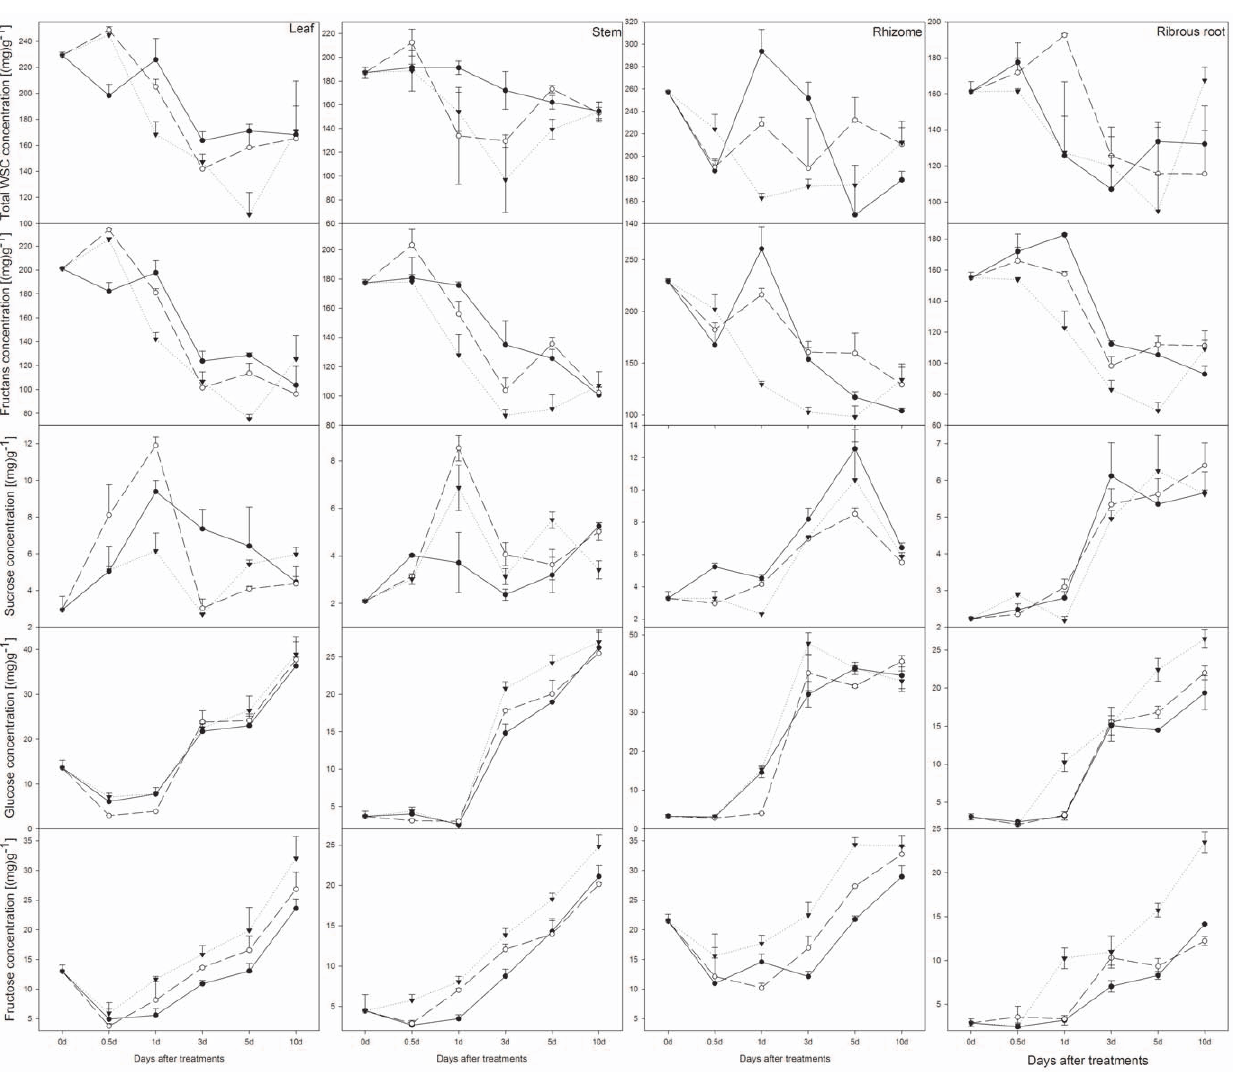
Figure 2. Response of carbohydrate concentrations. The differences between clipping without (real line) and with saliva (broken line) in carbohydrate concentrations, fructans (a 1 –a 4 ), sucrose (b 1 –b 4 ), glucose (c 1 –c 4 ) and fructose (d 1 –d 4 ) in component parts, leaf (a 1 –d 1 ), stem (a 2 –d 2 ), rhizome (a 3 –d 3 ) and fibrous root (a 4 –d 4 ), within 10 days after treatments in 2008. Bars represent standard errors. **, P , 0.05; *, P , 0.01. doi:10.1371/journal.pone.0029259.g002 PLoS ONE |